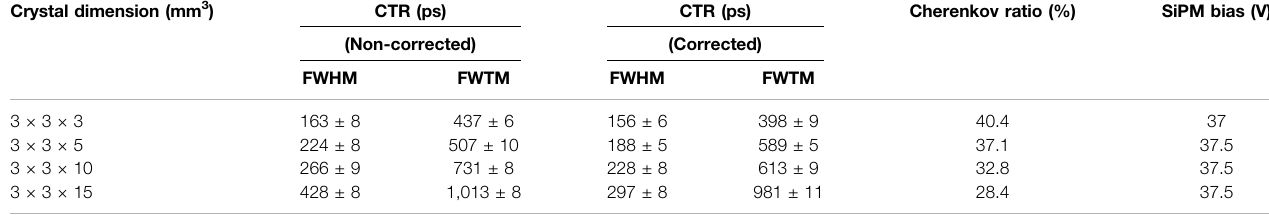
TABLE 2 | Best FWHM and FWTM CTR values and Cherenkov ratios obtained for each different crystal length before and after corrections. Crystal dimension (mm 3 )